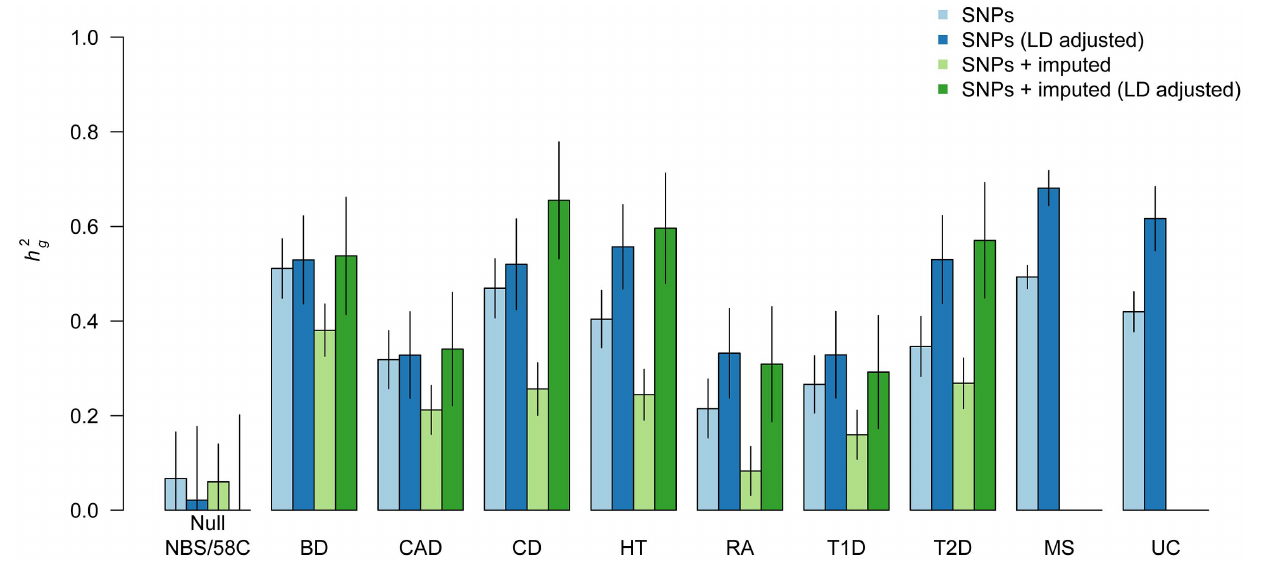
Figure 1. Heritability of genome-wide SNPs for nine complex traits. Components of heritability for typed markers (blue) over nine traits and imputed markers (green) over seven WTCCC1 traits shown. Light bars correspond to estimates from the standard variance-component and dark bars correspond to estimate from LD-adjusted variance-component. Two control sub-groups (NBS and 58C) tested against each other as negative control; diseases tested are Bipolar Disorder (BD), Coronary Artery Disease (CAD), Crohn’s Disease (CD), Hypertension (HT), Rheumatoid Arthritis (RA), Type 1 Diabetes (T1D), Type 2 Diabetes (T2D), Multiple Sclerosis (MS), Ulcerative Colitis (UC). Autoimmune traits (CD, RA, T1D, UC, and MS) excluded the well- studied MHC region. All traits exhibit an increase after LD adjustment, indicative of a genetic architecture that is shifted towards low-frequency causal variants. Error bars show analytical standard error of estimate.